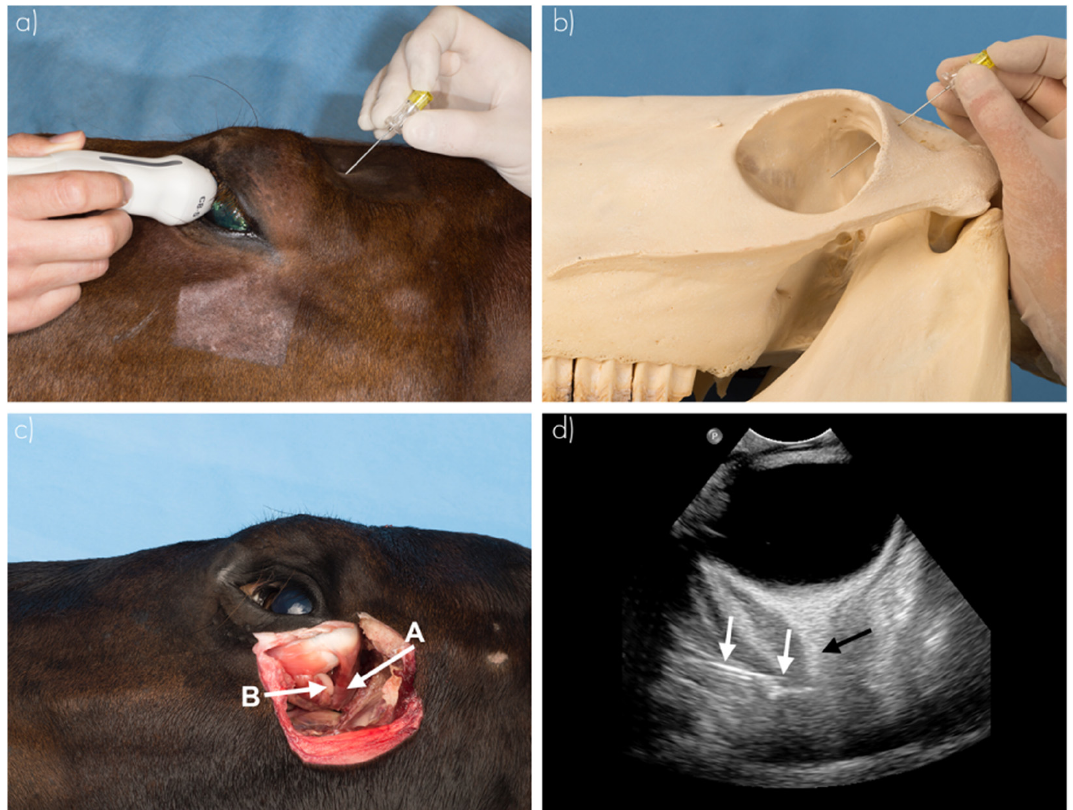
Figure 1. Ultrasound-guided retrobulbar nerve block (RNB). ( a ) Positioning of the ultrasound probe and the needle on the head. ( b ) Needle placement with respect to the bony landmarks. ( c ) Extrinsic straight eye muscles (A) within the covering fascia (cone) and the optic nerve in the center of the straight muscles (B). ( d ) Ultrasound image of retrobulbar needle placement and associated structures (white arrows show needle placement with tip at the height of the right arrow, black arrow shows the optic nerve)